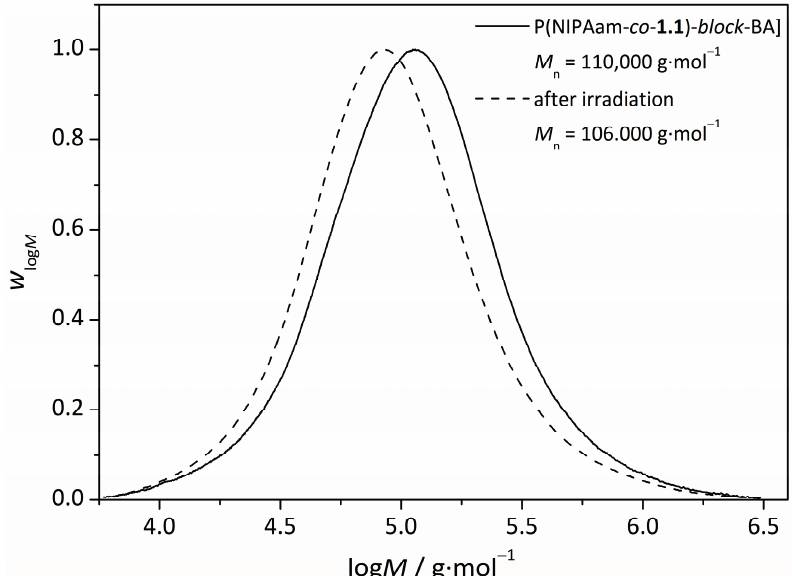
Figure 10. SEC-data, determined in DMAc, of a starpoly [(NIPAam- co - 1.1 ) 90 - block -BA 10 ] with a molecular weight of 110,000 g·mol − 1 (solid line) and the resulting polymer ( M n = 106,000 g·mol − 1 ) after UV-irradiation (dashed line) for 25 min using a UV mercury-vapour lamp of 100 W in acetone:diethyl ether